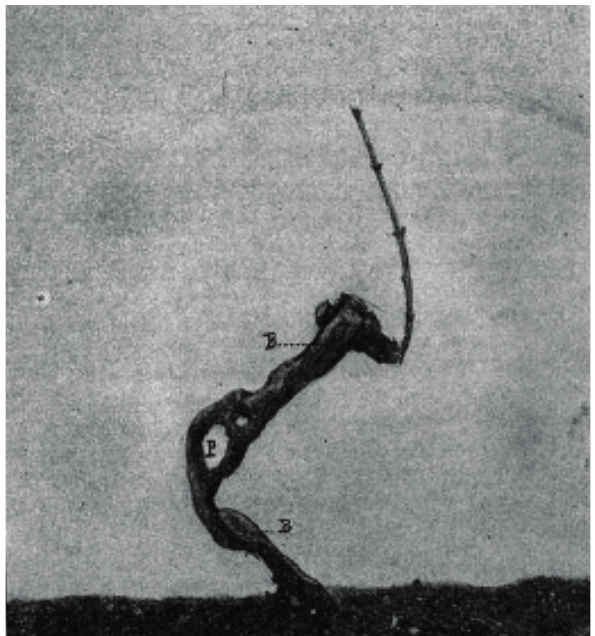
Figure 1. Illustration of a grapevine curetted in 1919, as shown by Lafon